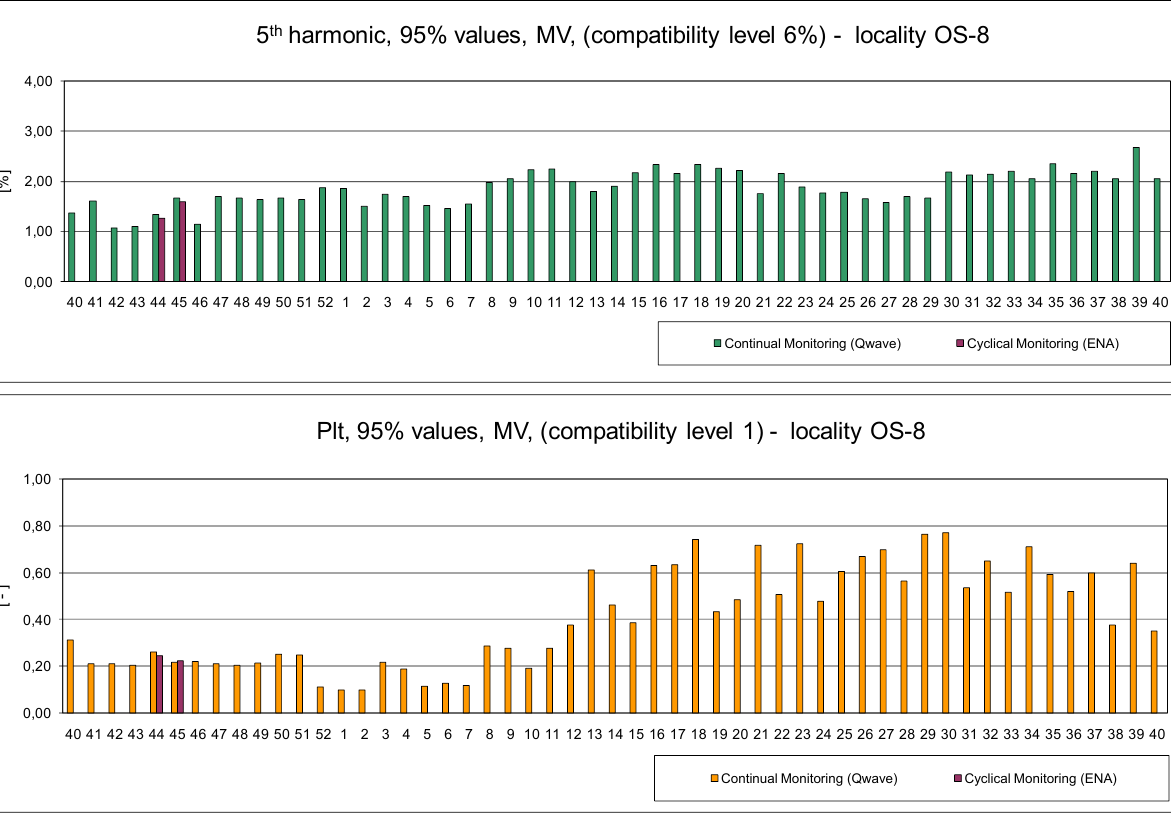
Fig. 7. 5 th harmonic and flicker (P lt ) in MV network